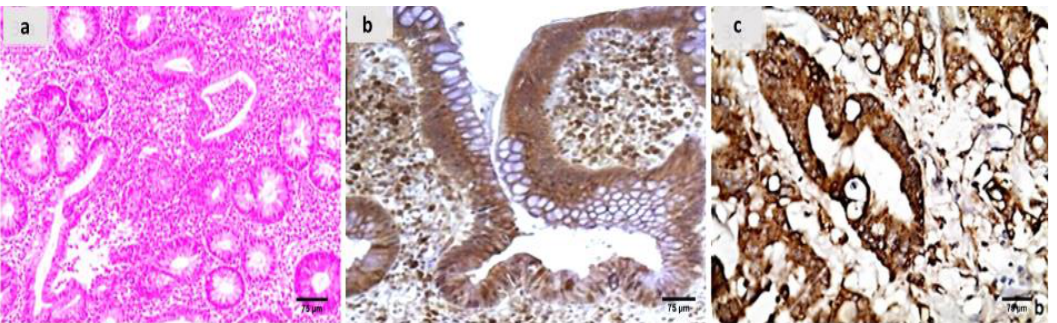
Figure 3. ( a ) A case of UC Geboes score 4.4 showed marked epithelial injury, cryptitis and ulcerations (H&E x200), ( b ) the same case showed positive calprotectin expression in the mucosal cells and the stroma (x200), ( c ) also showed positive S100A12 expression in the mucosal cells (x200).